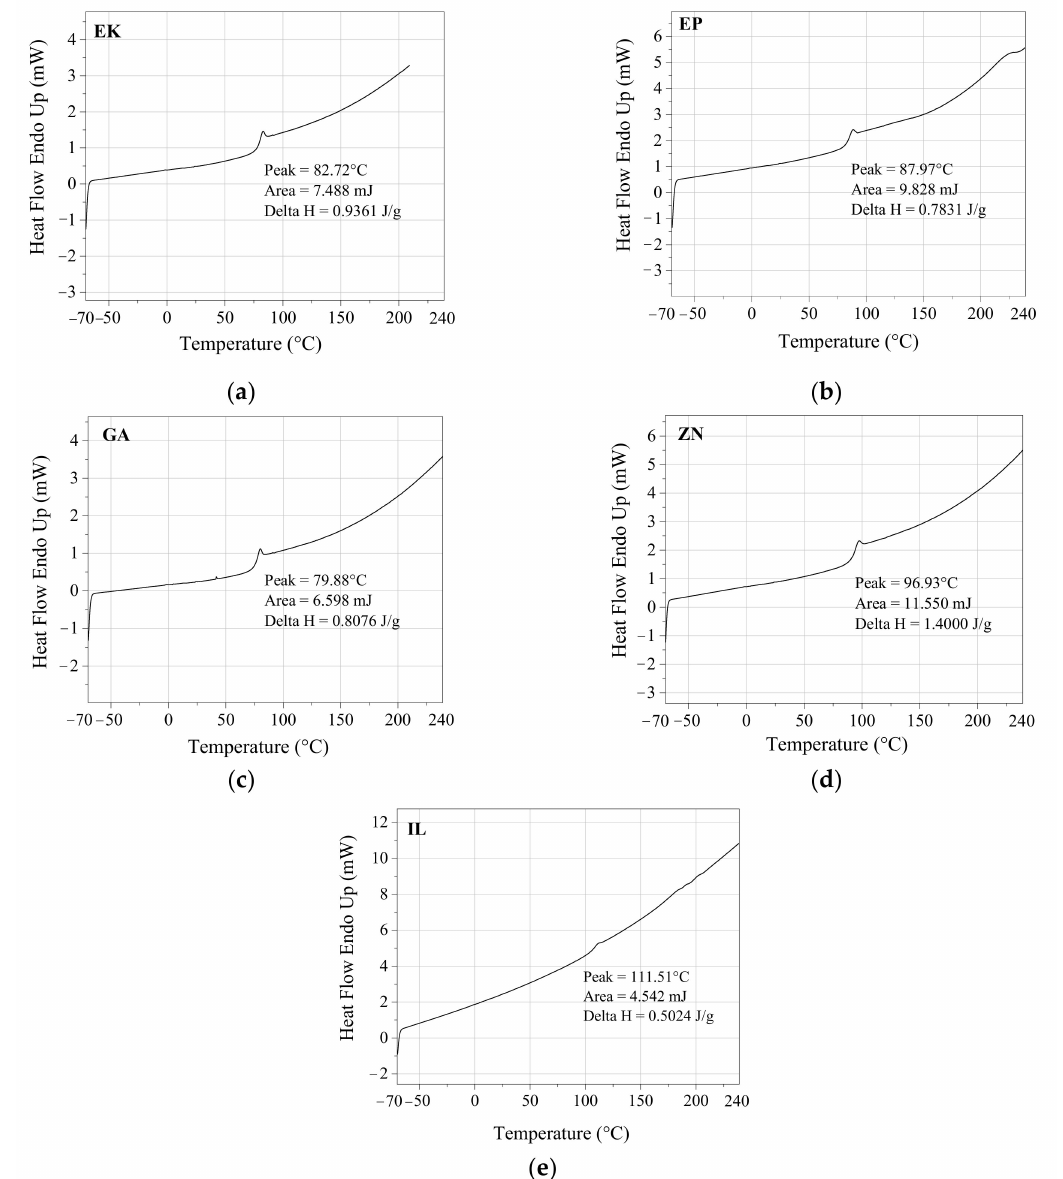
Figure 3. Differential scanning calorimetry (DSC) results for ( a ) Erkodur (EK); ( b ) Essix Plastic (EP); ( c ) Ghost Aligner (GA); ( d ) Zendura (ZN); ( e ) Invisalign (IL). The UV-visible absorbance curves of the clear aligners are shown in Figure 4. All the aligners present similar trends in wavelength. The EK, GA and EP samples show the lowest absorbance value in the visible range, underlining the high properties of transparency of these aligners, in agreement with the crystallinity degree (Table 3). On the contrary, IL was the least transparent sample, exhibiting the highest value of absorbency in the visible range. Despite of its amorphous structure and its FWHM value comparable with the GA and EP samples (see Table 3), the IL sample is the less transparent aligner probably due to a different thermoforming procedure or to its different chemical